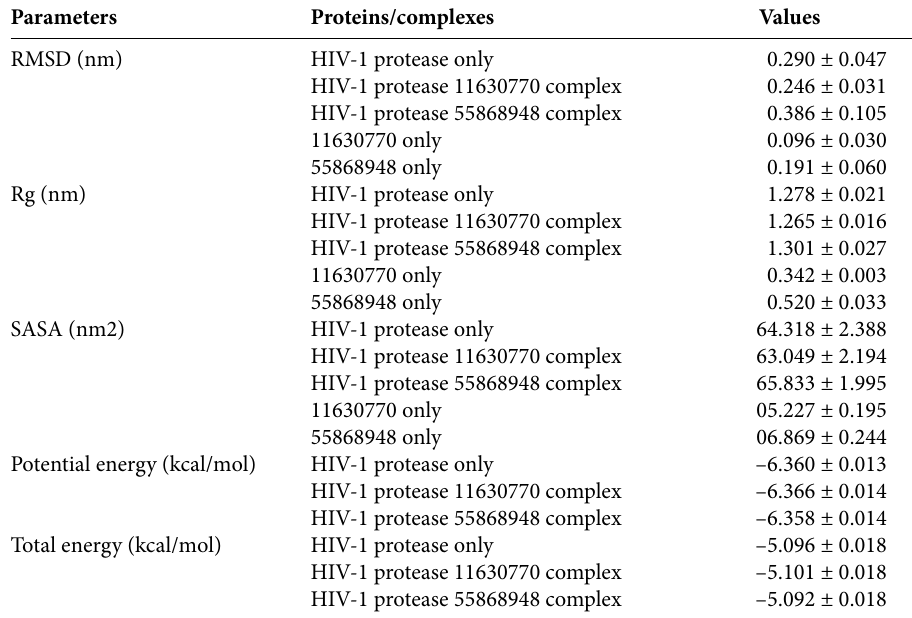
Table 8. Average RMSD, R g and SASA of HIV-1 protease alone, and their complexes calculated over 10000 frames of 100 ns MD simulation. Parameters